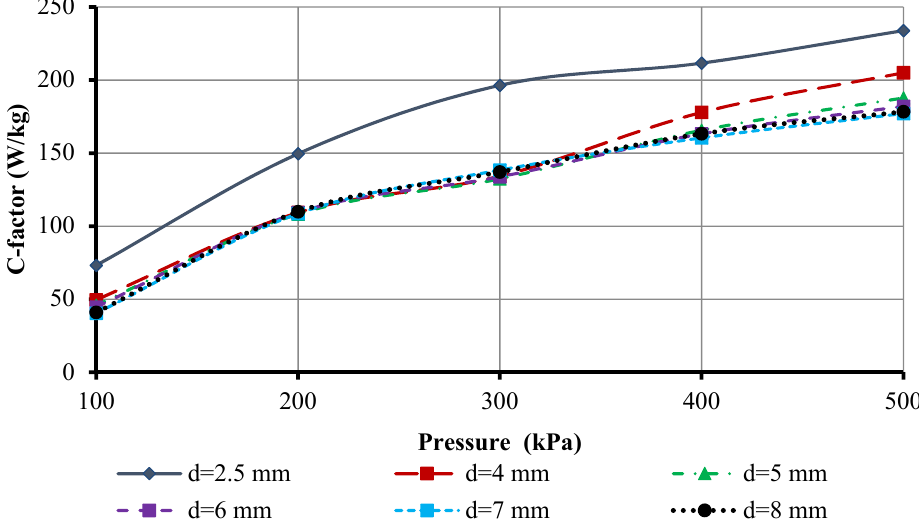
Figure 14. Influence of supply pressure on a BGD’s flow characteristics at different diameters of fitting constriction.